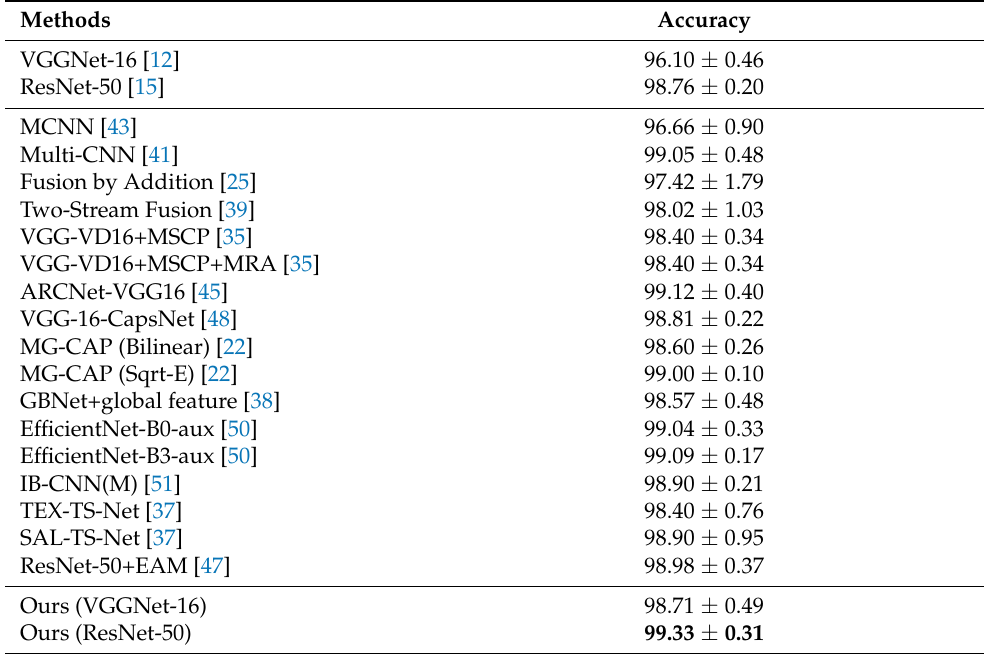
Table 2. The OA (%) and STD (%) of different methods on the UCML dataset.